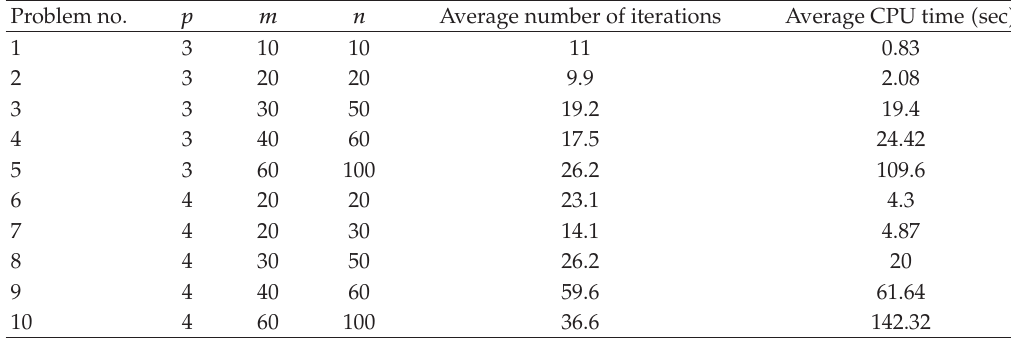
Table 1: Computational results on the problem of Type 1.